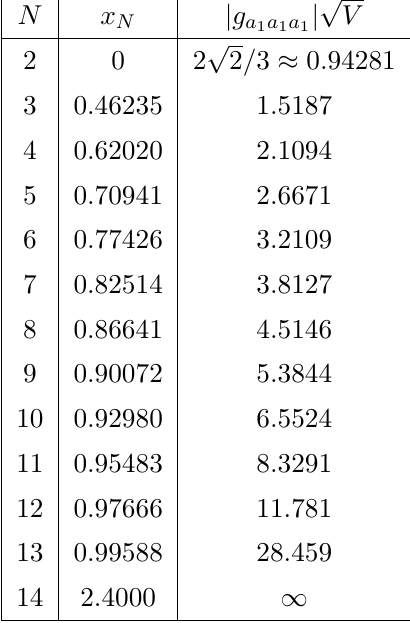
jp V for closed Einstein 1 a 1 a 1 g [ [ (cid:21) a ; 1 ) and x N is the 1 2